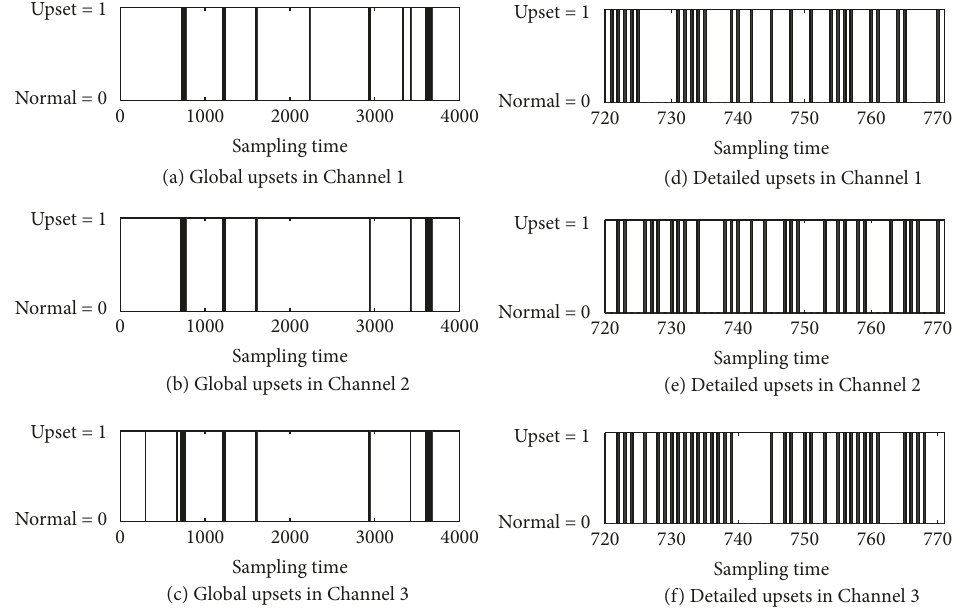
Figure 4: Digital upsets distribution of each channel over three-CPE configuration generated by MDHMM